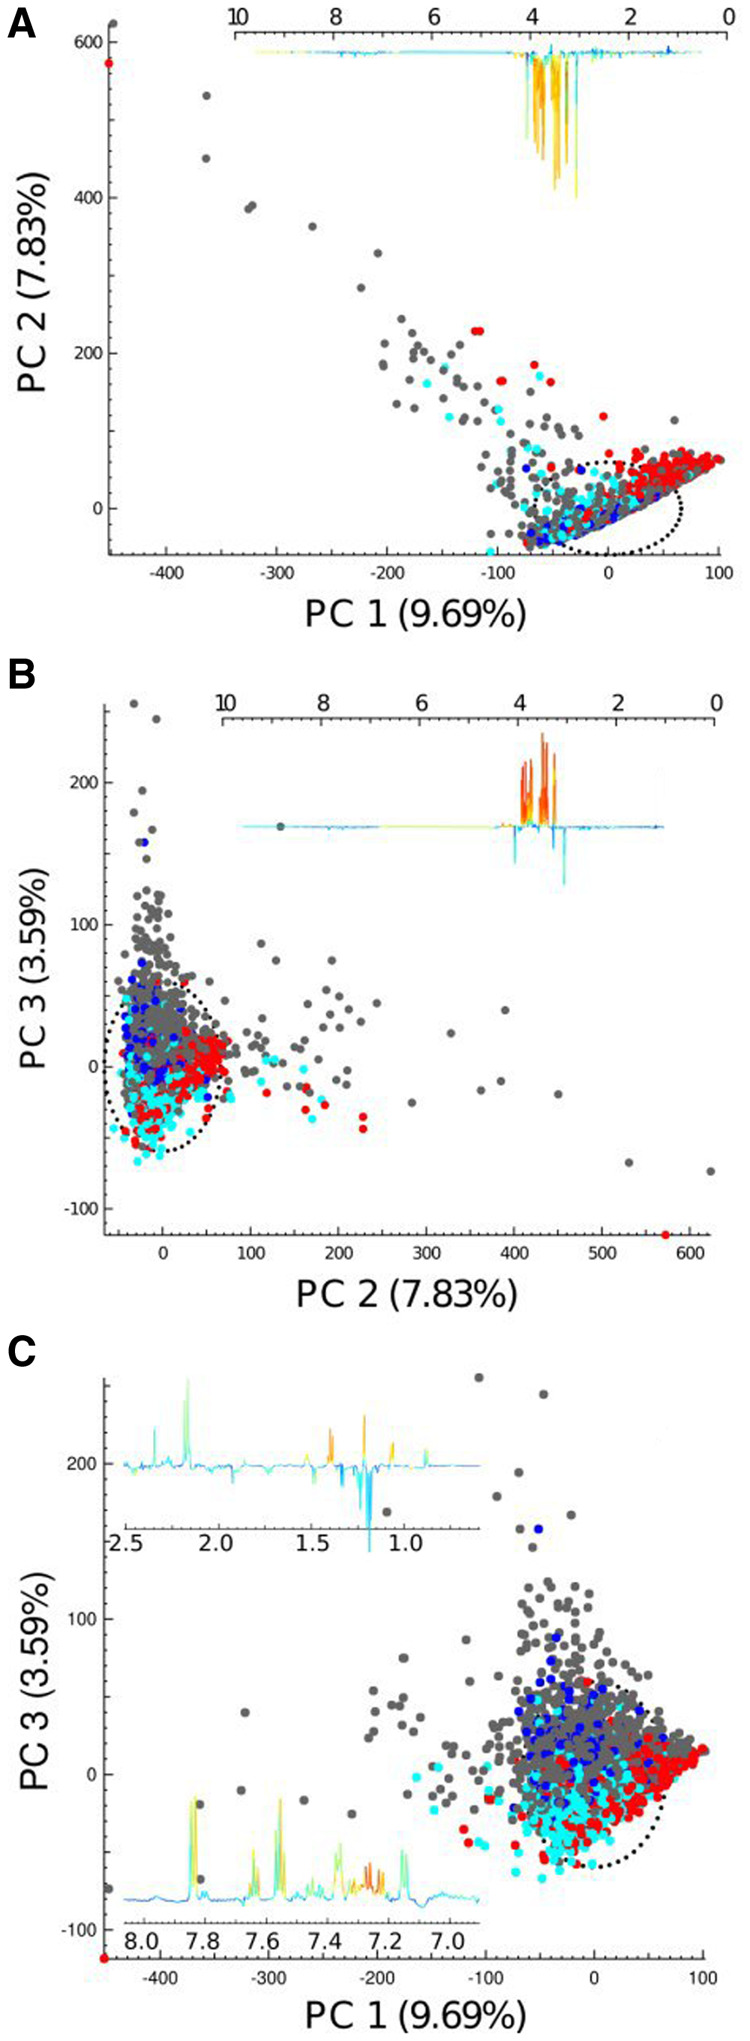
PCA model of the global (total spectrum) showing (A) scores plots for PC 1 and 2 and loading for PC 1 dominated by glucose metabolites; (B) scores plots for PC 2 and 3 and loading for PC 2 also dominated by glucose metabolites and (C) scores plots for PC 1 and 3 and loading for PC 3 dominated by ibuprofen and its related metabolites (in the region between 0.5 and 1.5 ppm), acetaminophen and its related metabolites (region around 2.13 ppm and between 7.1 and 7.4 ppm) and hippurate (region around 7.5–7.8 ppm). All PCA scores plots are colour coded to country: China (red), Japan (turquoise), UK (blue) and USA (grey)